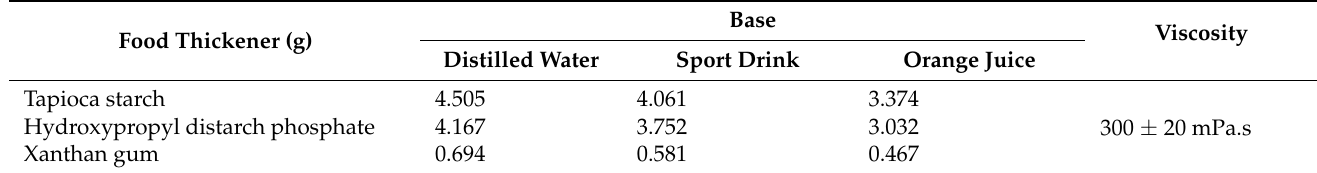
Table 2. Formula of thickened nectar-like fluids *.